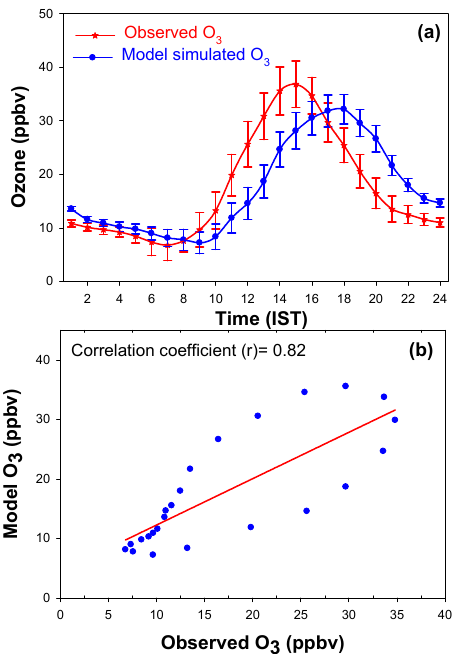
Figure 10. Yearly average (over the period 2013–2018) ( a) diurnal profile of measured and modeled O 3, ( b ) correlation between modeled O 3 and measured O 3 .